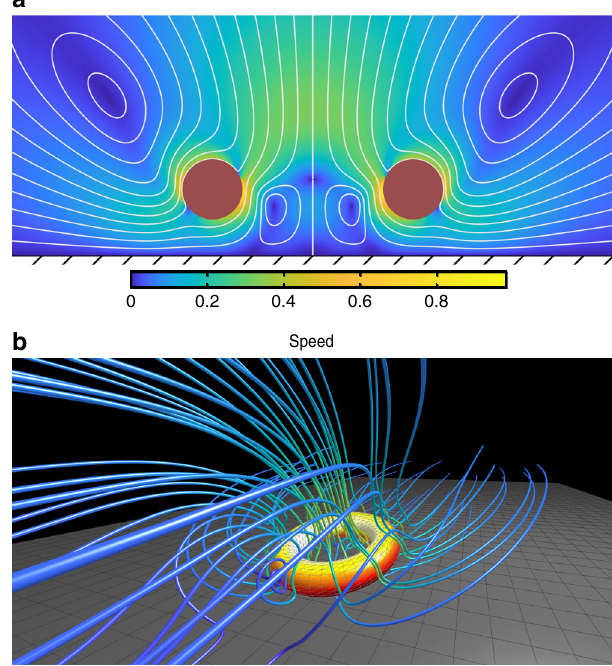
Fig. 7 Flow streamlines generated by a patchy (glazed) torus. a Flow streamlines produced by an active, uncharged torus, hovering above a plane boundary, with nondimensionalized speed. b Flow streamlines and surface concentration of a steady gliding torus, at an angle of 12 (cid:4) , shown in the frame in which the torus is